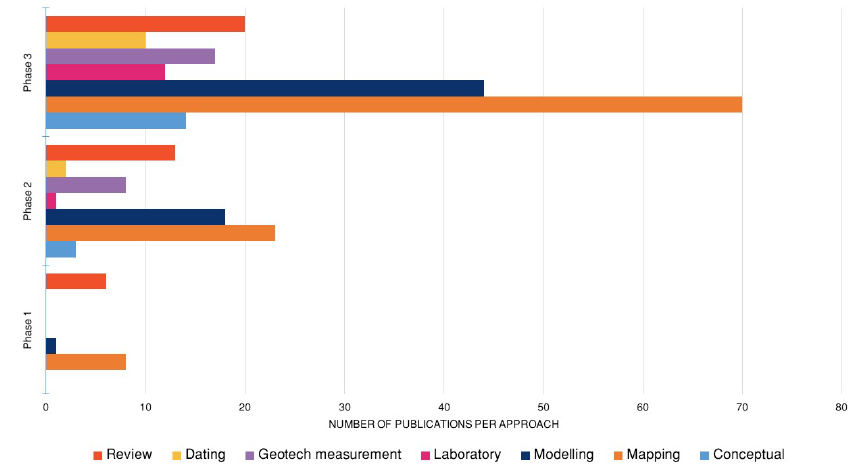
Figure 14. The number of each approach in peer-reviewed publications between 1982 and 2016.